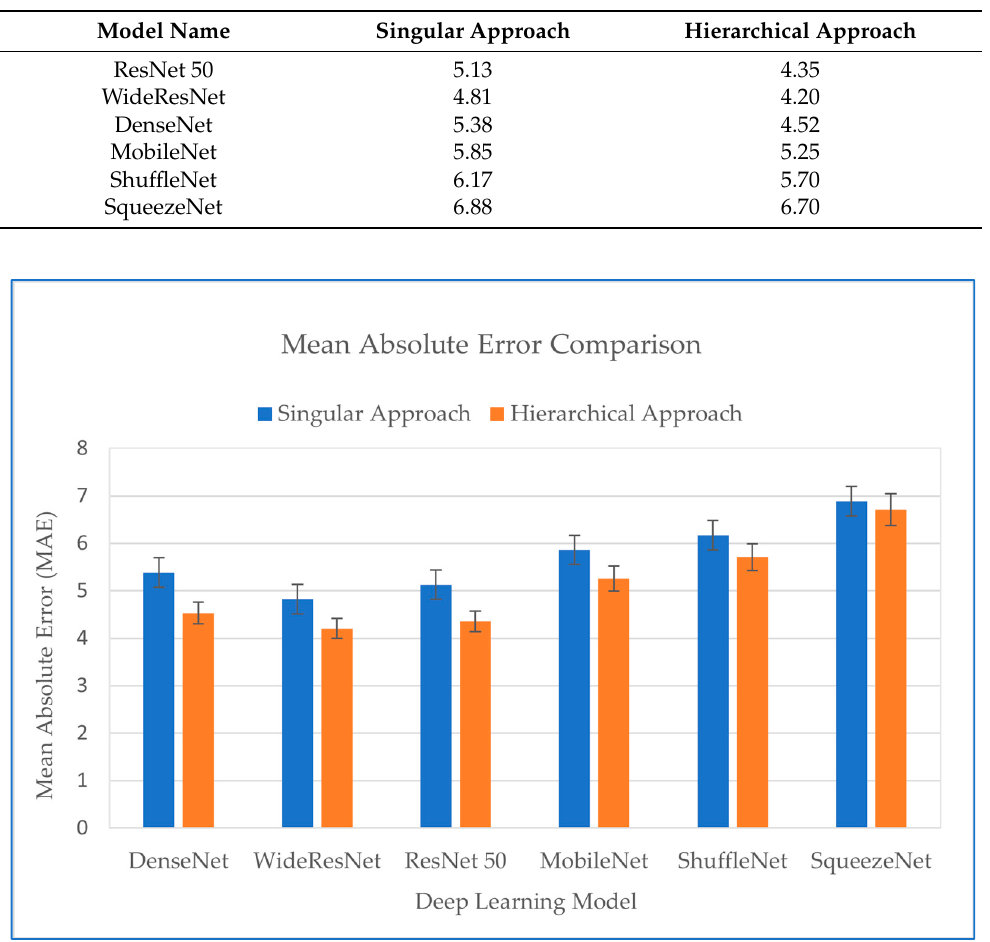
Table 2. Mean absolute error values regarding real age estimation over synthetic masked IMDB- WIK dataset.